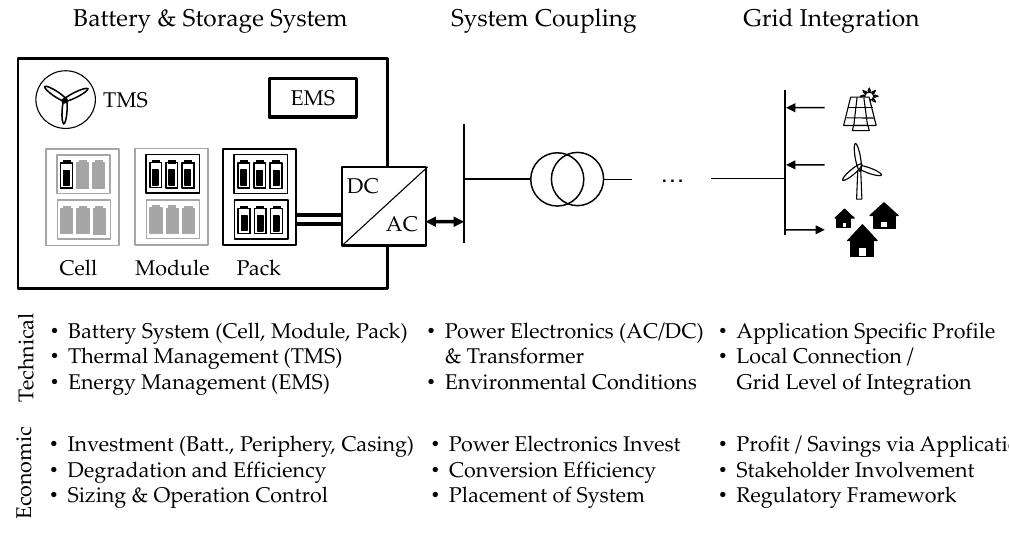
Figure 1. Formalized schematic drawing of a battery storage system, power system coupling and grid interface components. Keywords highlight technically and economically relevant aspects analyzed in this